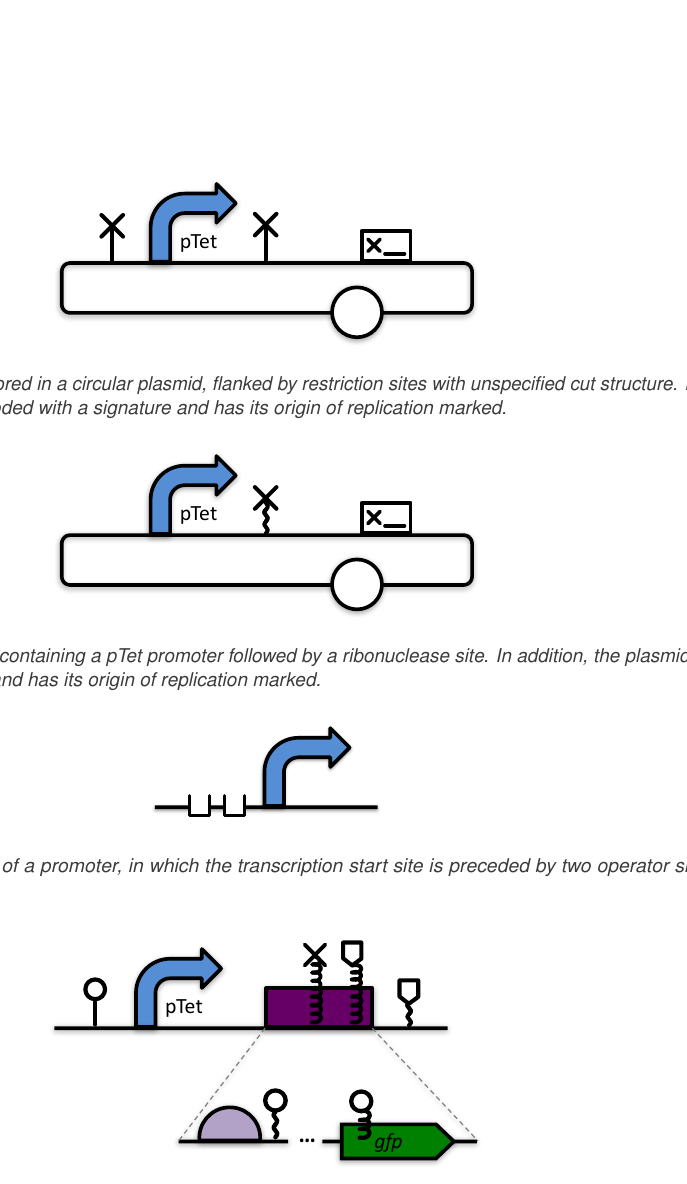
Figure 34: Promoter regulating the production of an engineered composite sequence that includes RNA and protein stability elements at its 3’ end, as well as an internal site for protease cleavage, as well as the expansion of the composite to show it contains a ribosome entry site. coding sequence, and other omitted details. Single residue locations of interest are indicated for the DNA (before the promoter), RNA (after the ribosome entry site), and protein (in the CDS).